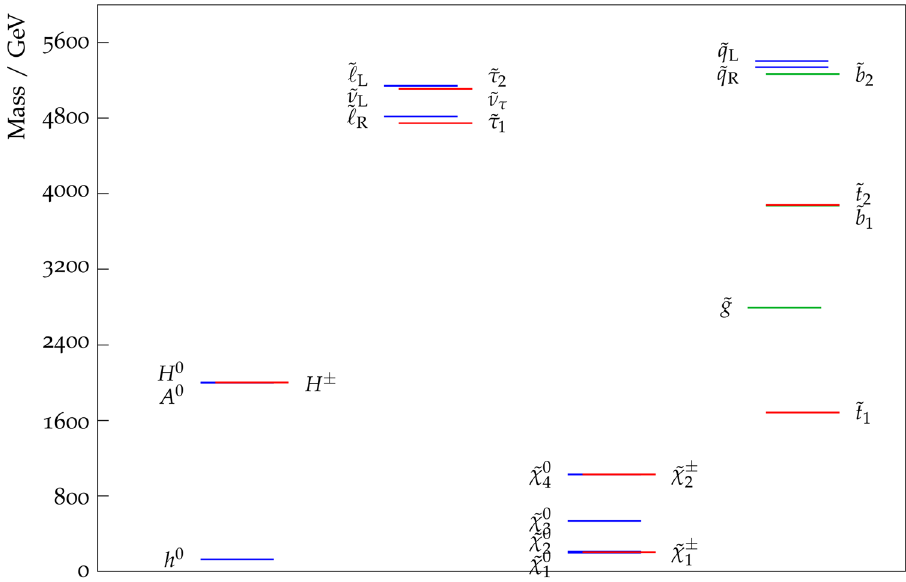
Fig. 1 Sparticle and Higgs mass spectra for a natural SUSY benchmark point from SOFTSUSY